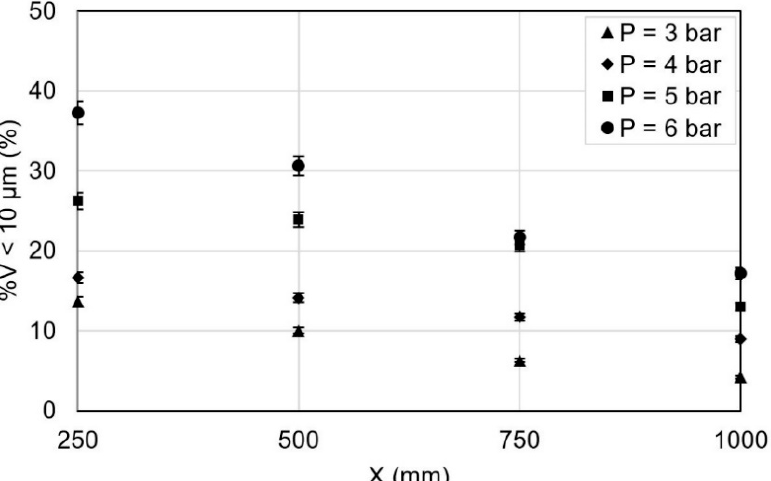
Figure 10. Dependence of volume fraction of droplets with diameters smaller than 10 µm on the distance from nozzle outlet (for α = − 45°).